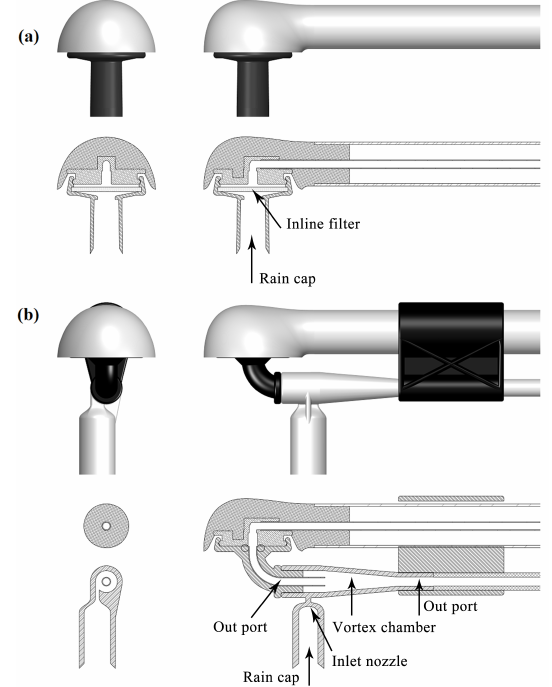
Figure 2. EC155 sample intakes: (a) original inline filter and (b) prototype vortex intake (source: Campbell Scientific Inc., Lo- gan UT,